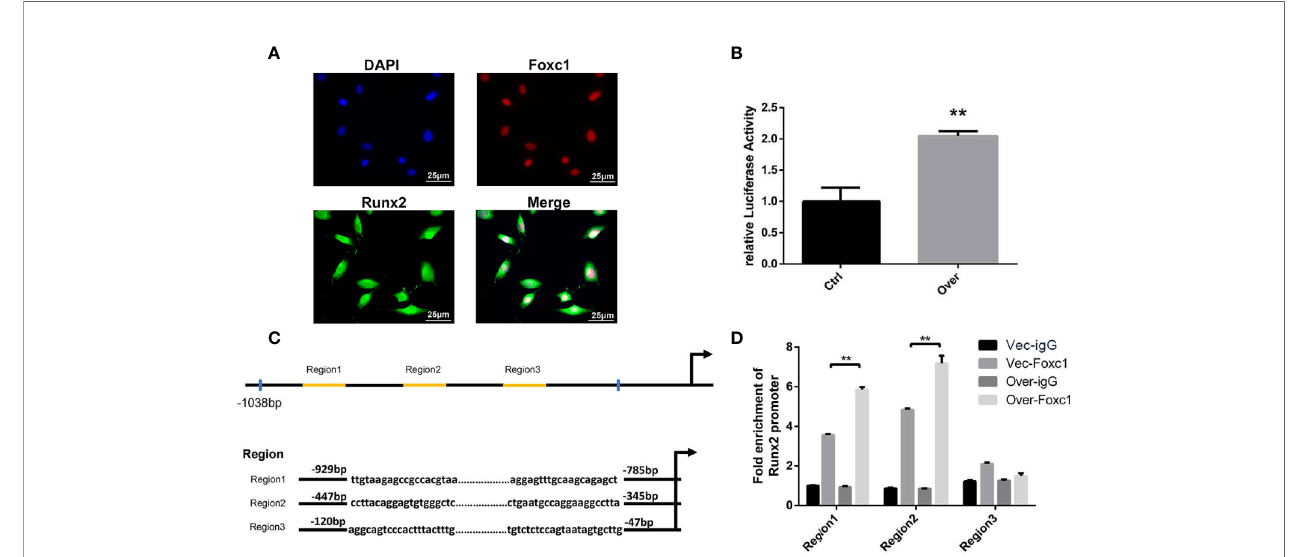
FIGURE 4 | Foxc1 directly regulated transcriptional activity of Runx2 by binding to its promoter. (A) Expression of Foxc1 and Runx2 in MC3T3-E1 cells by immuno fl uorescence analysis. (B) Luciferase reporter assay of Runx2 promoter activity. (C) Putative Foxc1-binding sites in the proximal promoter region of the mice Runx2 gene. (D) Chromatin immunoprecipitate obtained in the ChIP assay quanti fi ed by qPCR for detecting the binding of Foxc1 to the Runx2 gene promoter region. Scale bar = 25 m m. ** p <